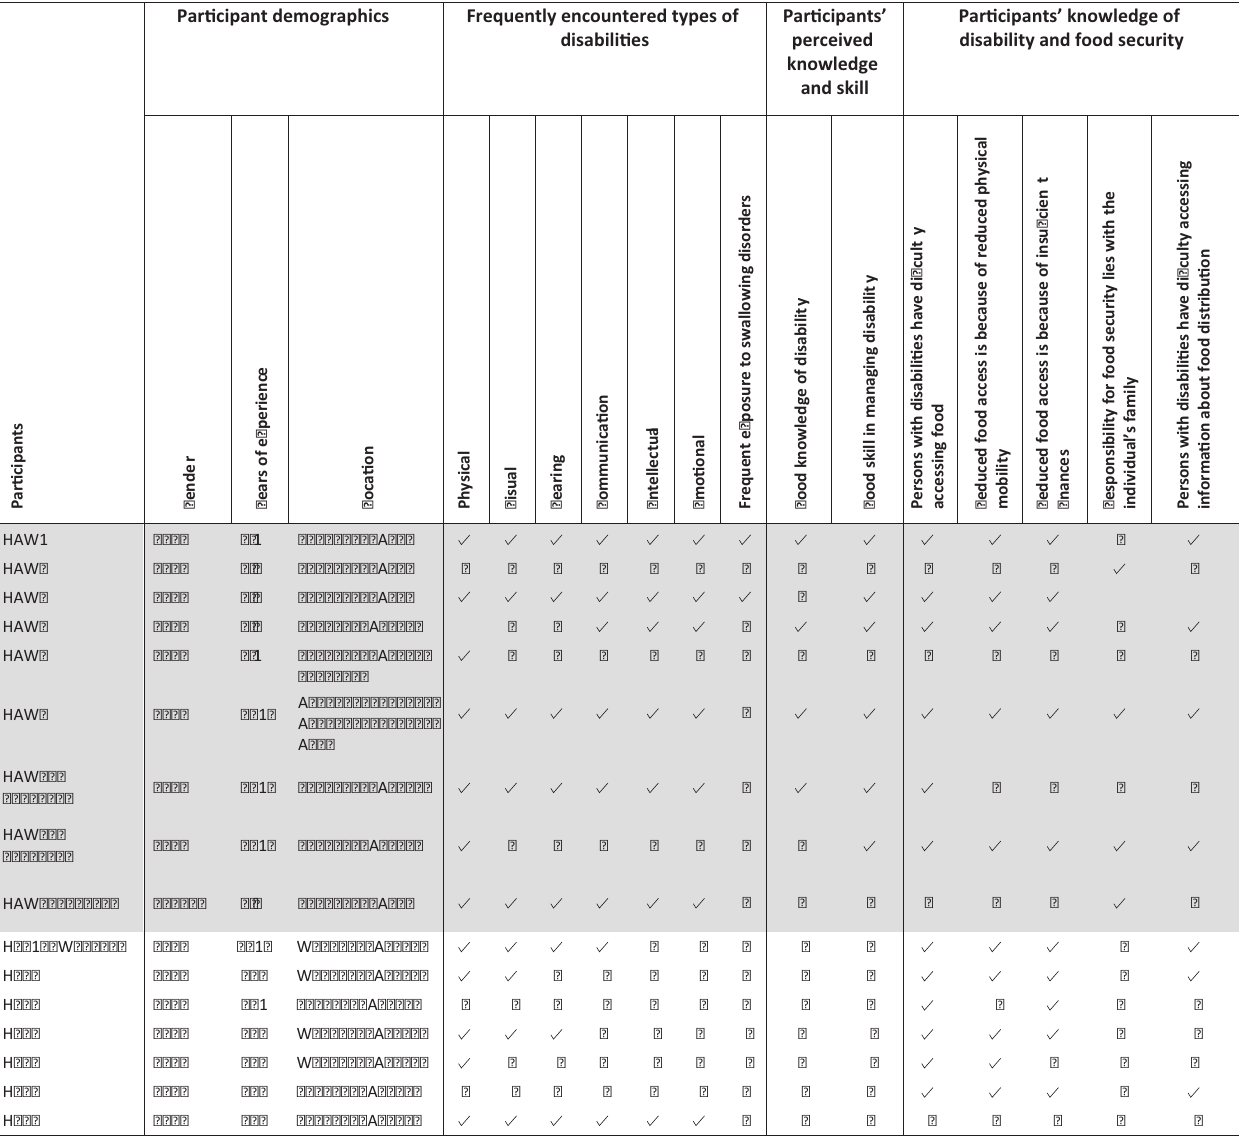
Figure 2 reflects participants’ demographic data as well as specific responses from the survey and interviews. ‘Good’ knowledge and skill indicates participant survey responses indicating the two highest ratings (‘always’ or ‘often’) on a Likert scale. FIGURE 2: Summary of study results.